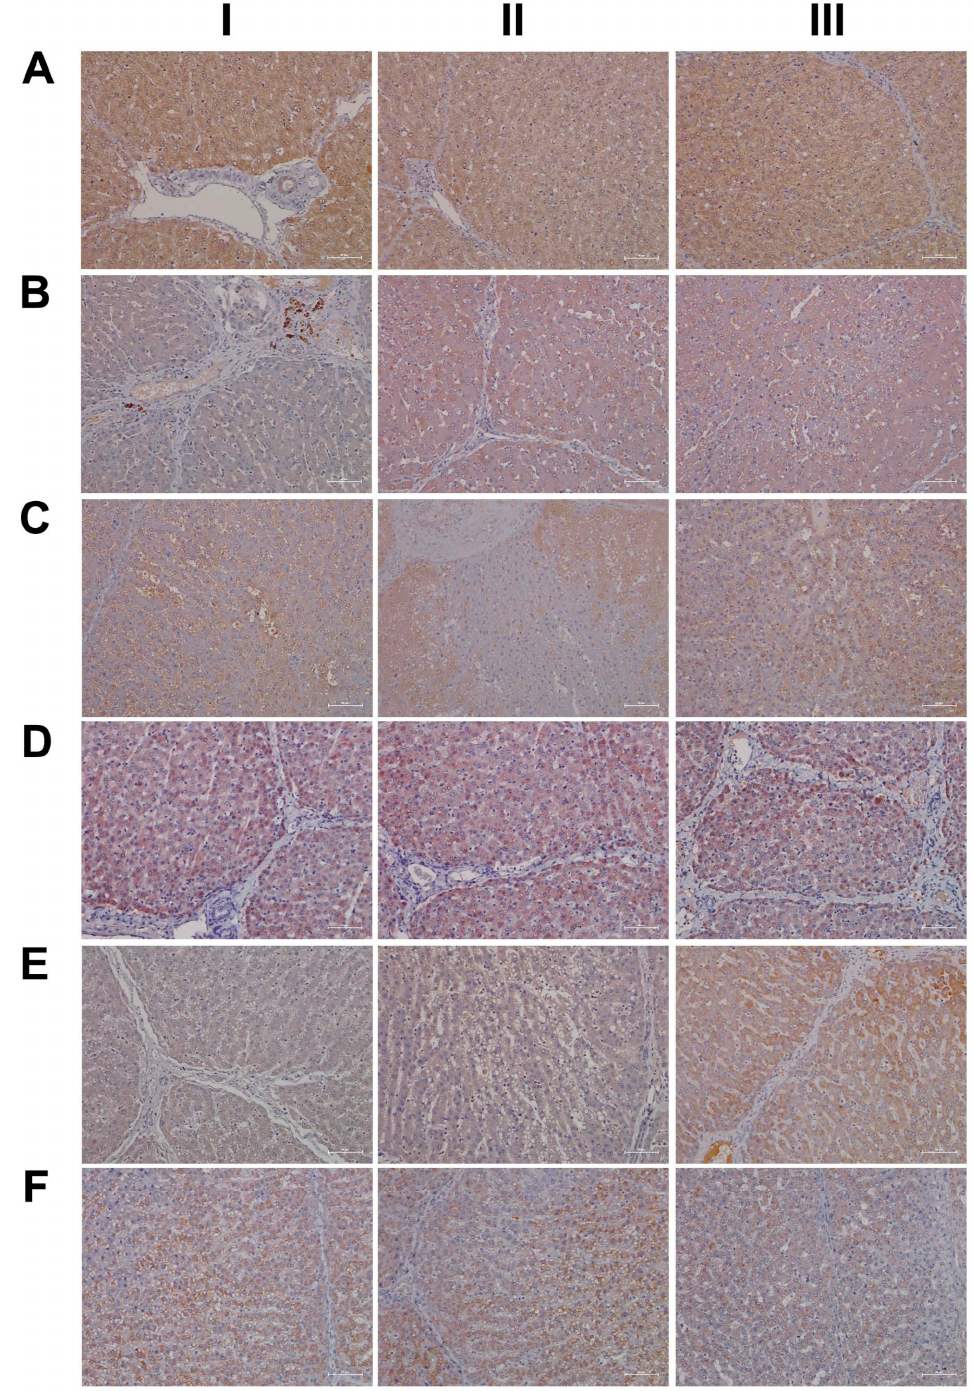
Figure 4. Immunohistochemistry of superoxide dismutase SOD1 and SOD2 in liver sections of control and diclofenac-treated animals after daily dosing for 28 days. Superoxide dismutase 1 and 2 are of